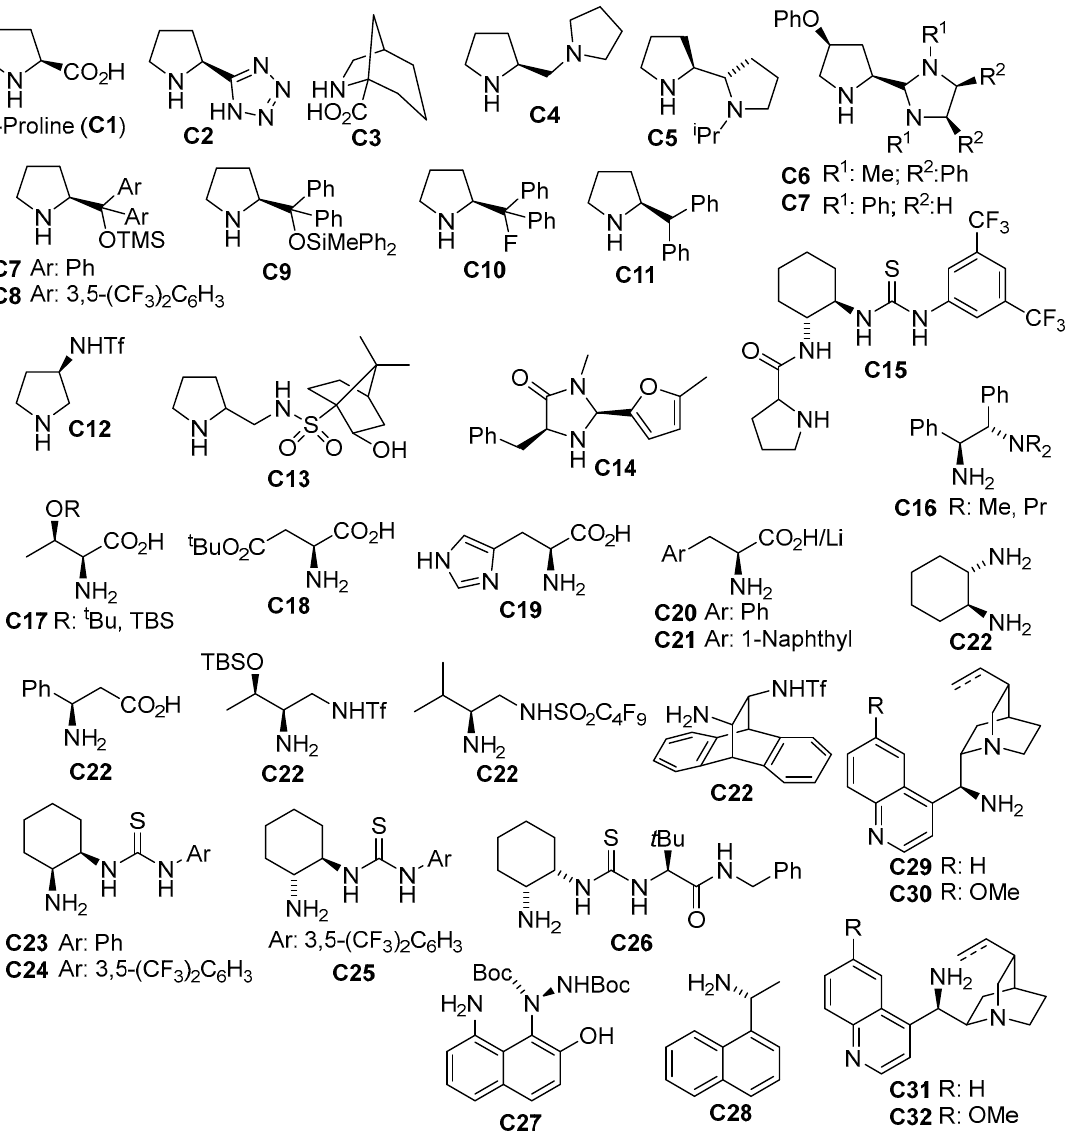
Figure 1. Representative primary and secondary amine catalysts used for enamine-mediated synthesis of α -quaternary aldehydes until the year 2014.